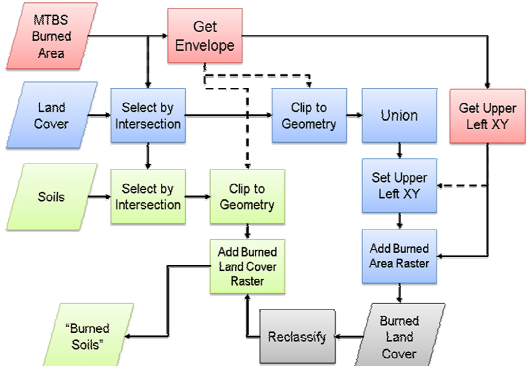
Figure 6. Example geo-processing workflow for the soils layer.